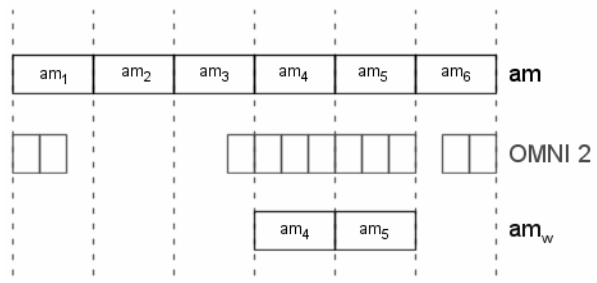
Figure 2 Fig. 2. Illustration of the formation of am w from am and the avail- ability of OMNI 2 hourly means. Values for each 3-h period are taken from am , while the presence or absence of a record is deter- mined by whether a matching 3h of OMNI 2 data is